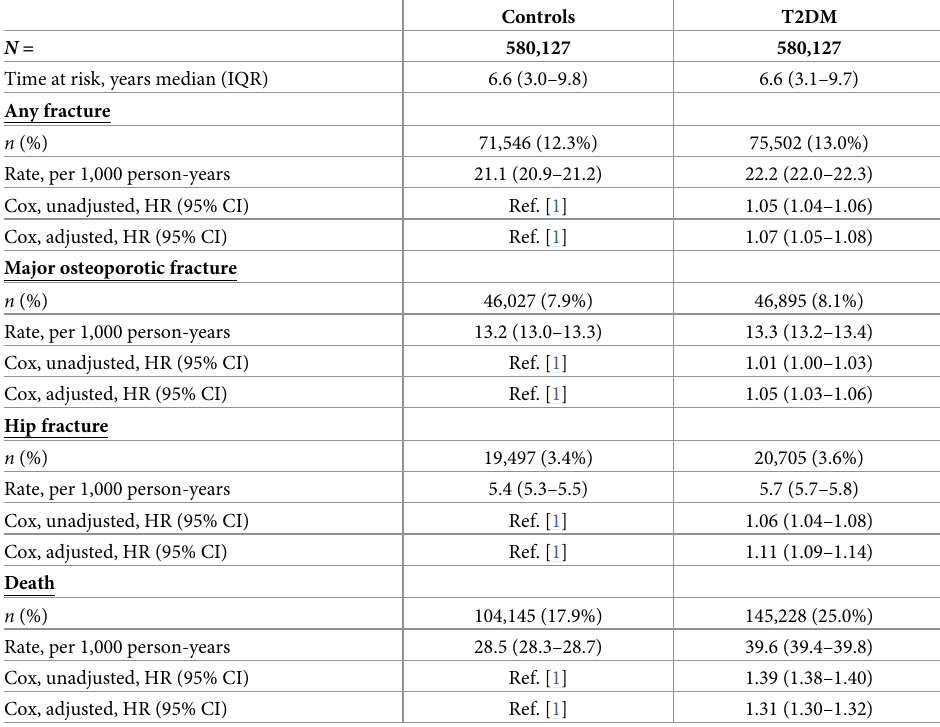
Table 2. Fracture outcomes in patients with type 2 diabetes and controls.